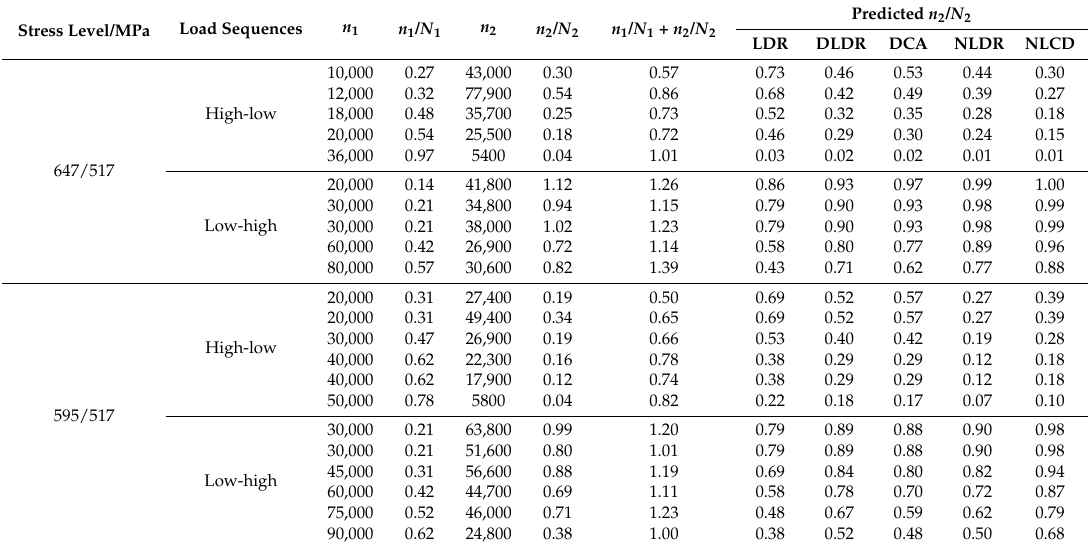
Table 2. Test results under one-way two-level